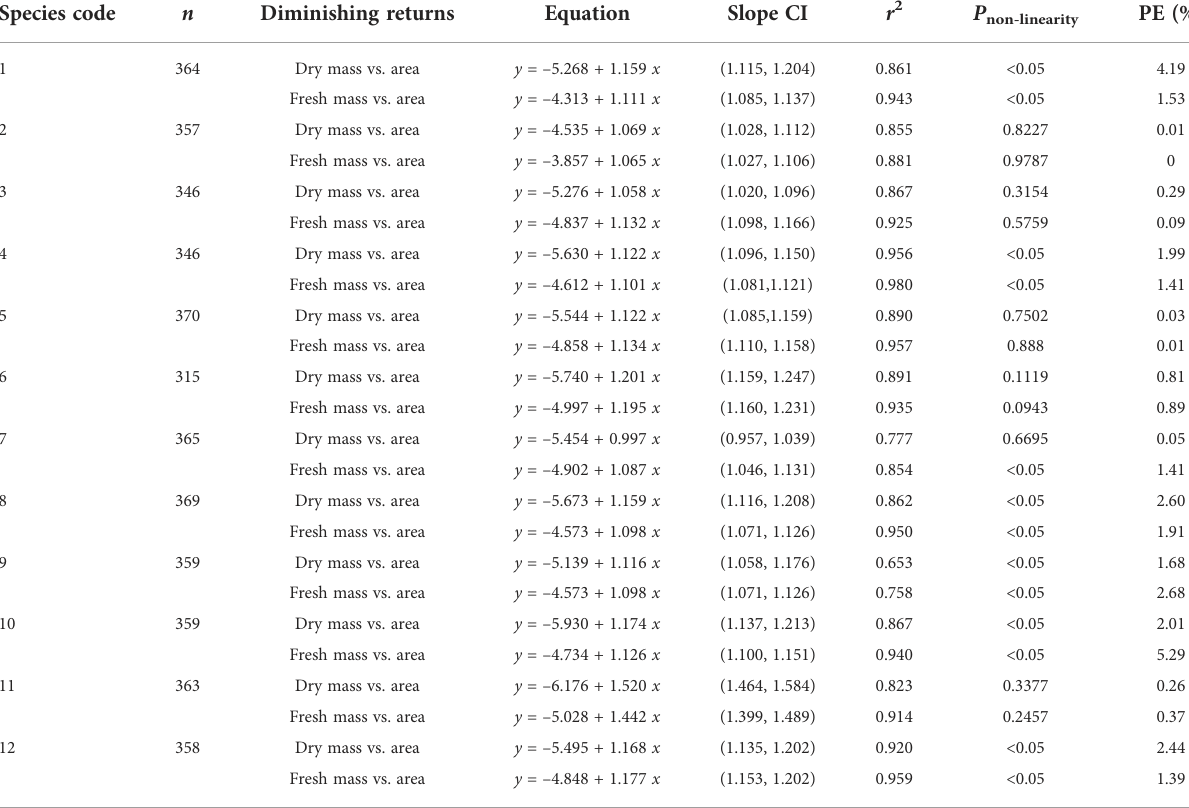
TABLE 2 Statistical parameters for dry mass vs. area and fresh mass vs. area in 12 species. Species